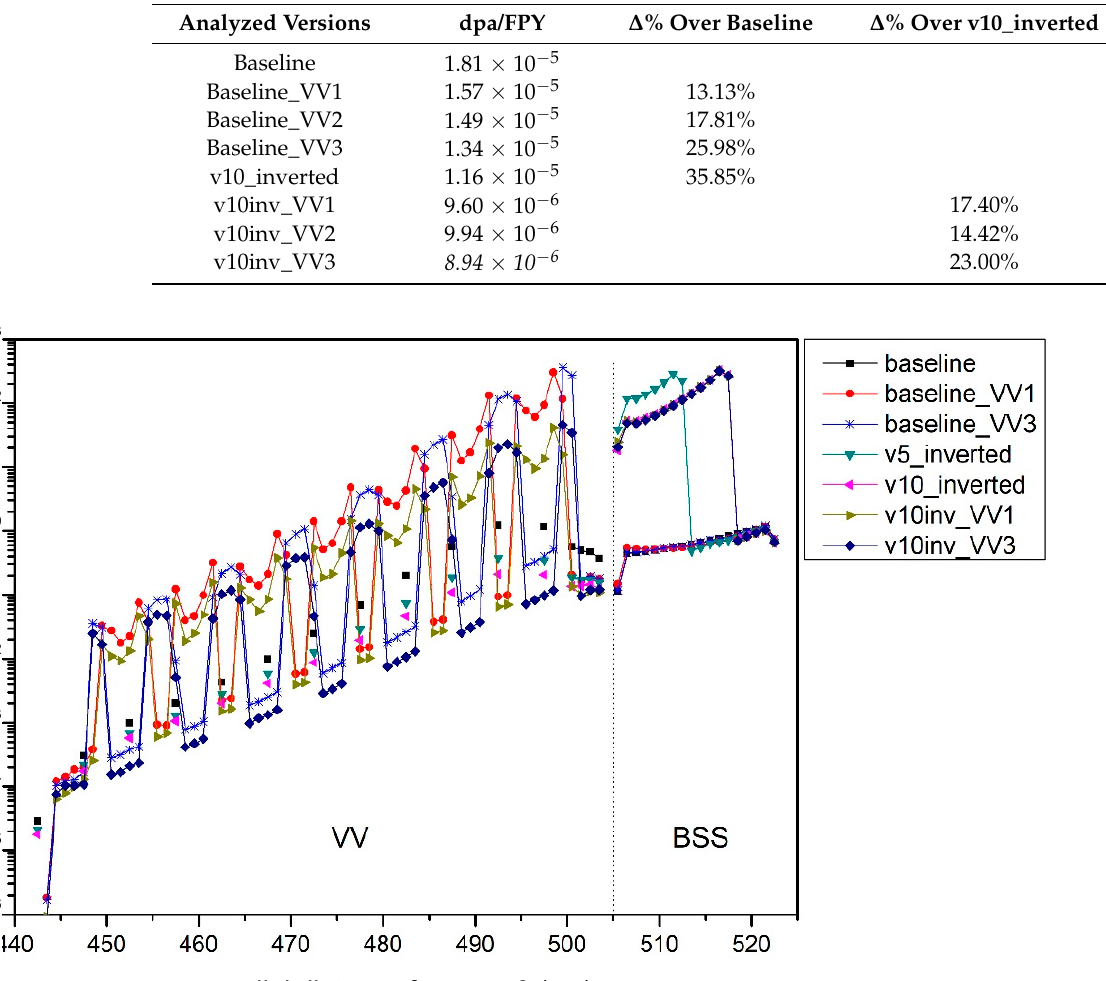
Table 10. Damage function (dpa/FPY) at first radial cm of the TFC for the baseline and v10_inverted versions with modified VV.